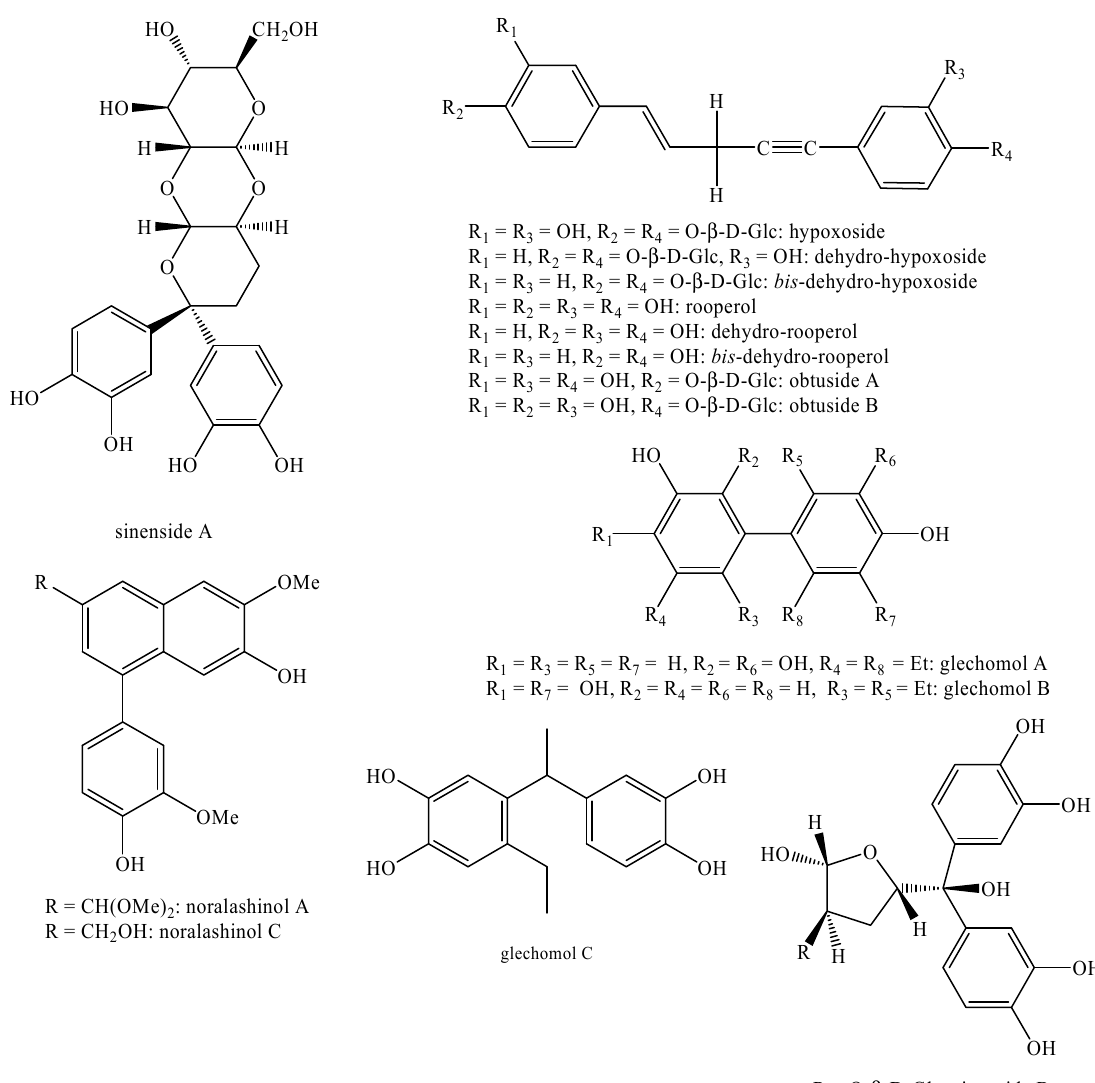
Figure 12. Isolated nor -lignans in the plant kingdom—part 11.